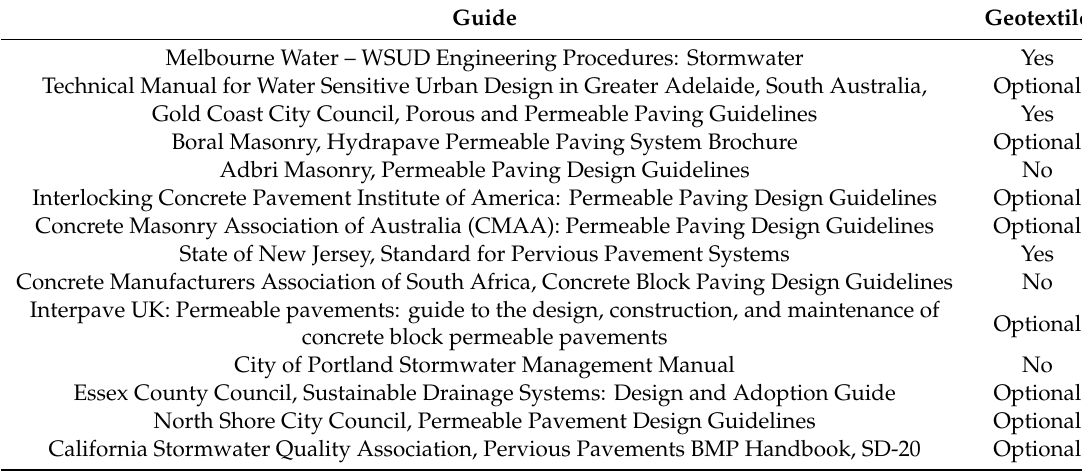
Table 1. Di ff erent recommendations on the use of geotextiles in pervious pavements [4]. Guide Geotextile Melbourne Water – WSUD Engineering Procedures: Stormwater Yes Technical Manual for Water Sensitive Urban Design in Greater Adelaide, South Australia, Optional Gold Coast City Council, Porous and Permeable Paving Guidelines Yes Boral Masonry, Hydrapave Permeable Paving System Brochure Optional Adbri Masonry, Permeable Paving Design Guidelines No Optional Optional State of New Jersey, Standard for Pervious Pavement